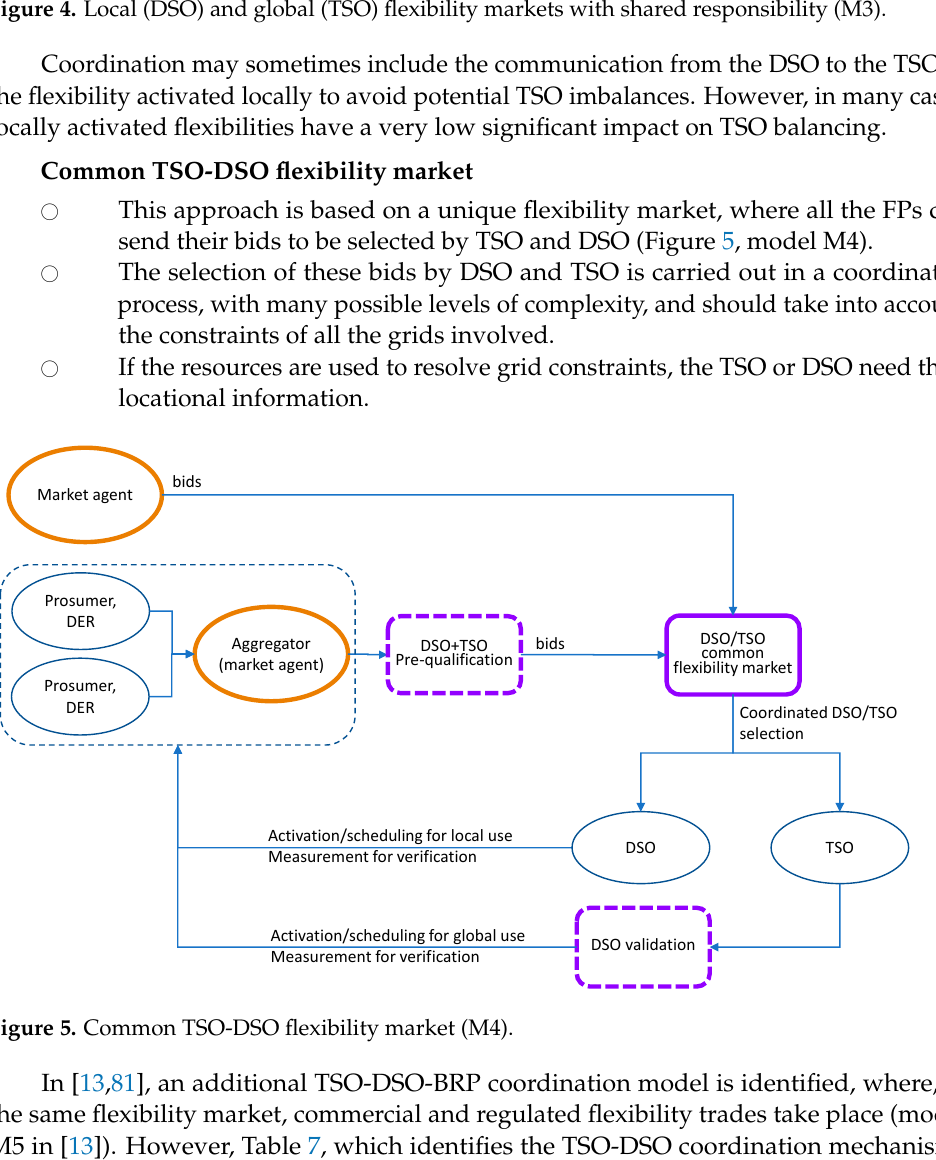
Figure 4. Local (DSO) and global (TSO) flexibility markets with shared responsibility (M3).